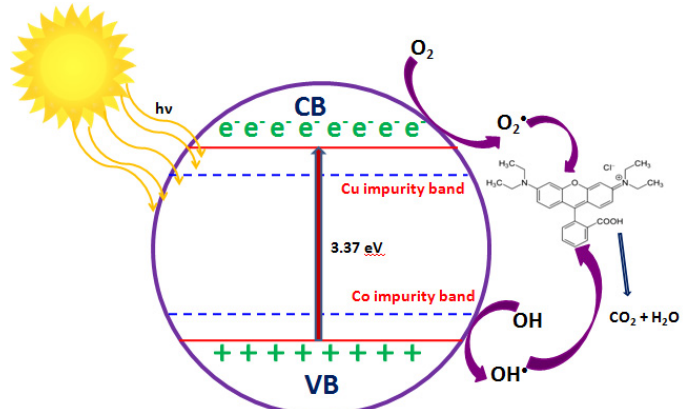
Fig. 9. Schematic illustration of the modification of ZnO due to metal doping as impurities